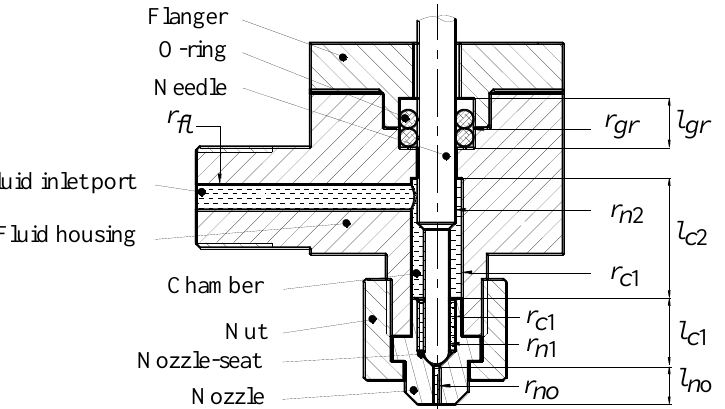
Figure 4. Jet valve configuration.